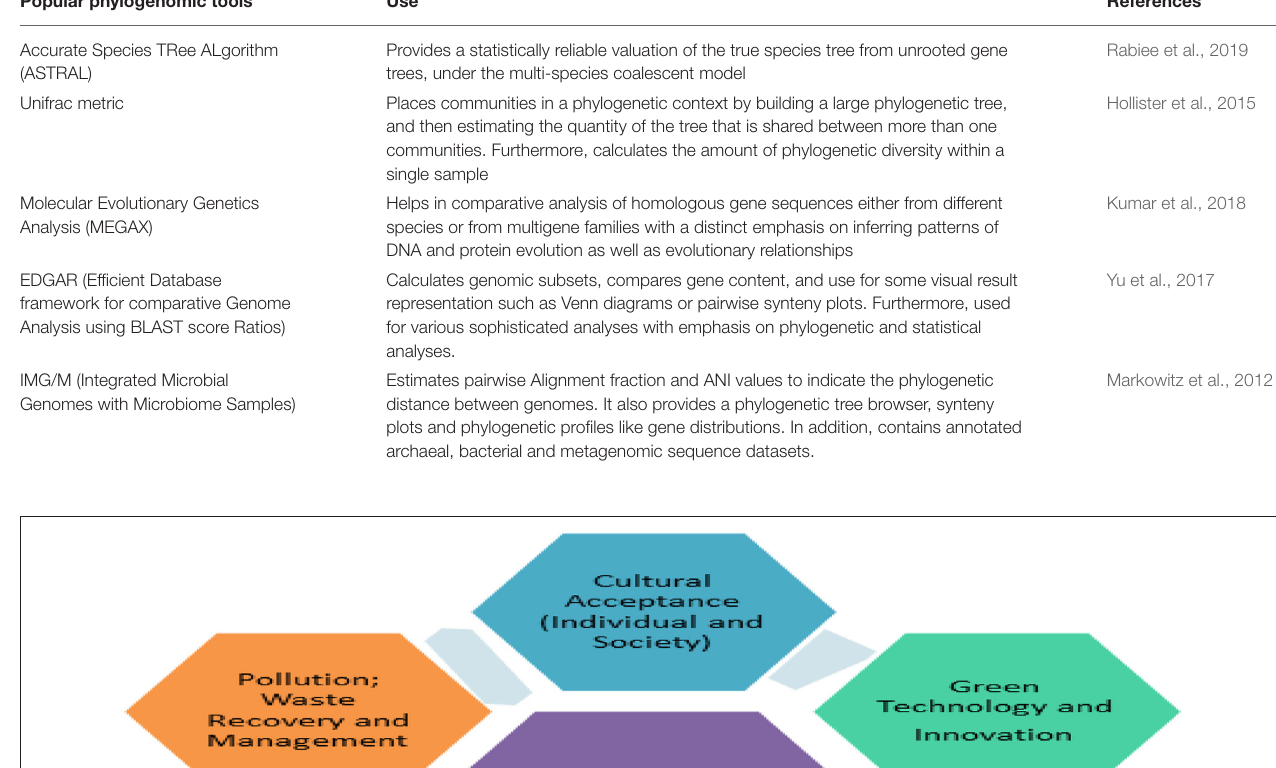
TABLE 3 | Some popular phylogenomic analytical tools for phylogenetic and taxonomic classification. Popular phylogenomic tools